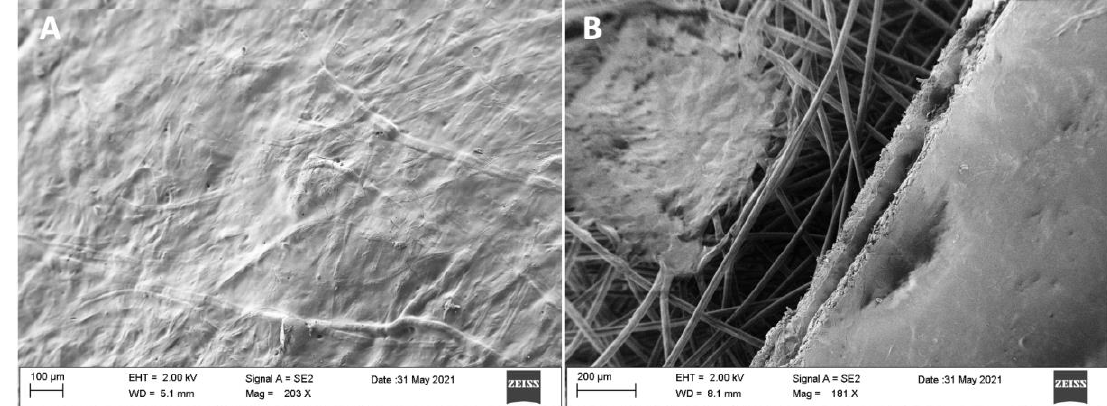
Figure 3. SEM image of PEDOT:PSS + H 2 TPyP on the internal surface of FPP2 face mask. ( A ) polymer–molecular mixture is homogeneously distributed onto the surface, and the underlying cellulose fibers are visible. ( B ) a lateral view of a cracked film shows the compact layered arrangement of the sensitive film. The stratifications of layers correspond to successive steps of deposition.